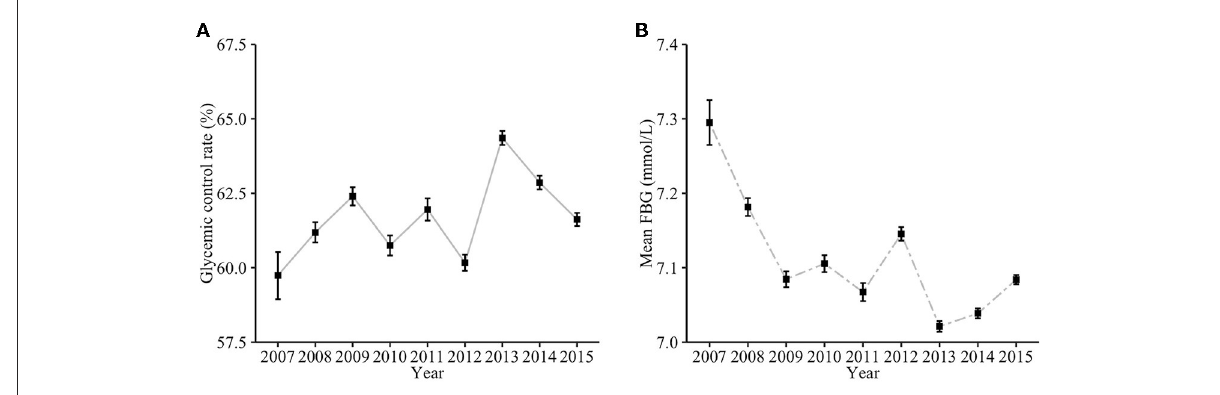
FIGURE2 The annual glycemic trend of community-managed patients with T2DM from 2007 to 2015. (A) Glycemic control rate; (B) Mean FBG.